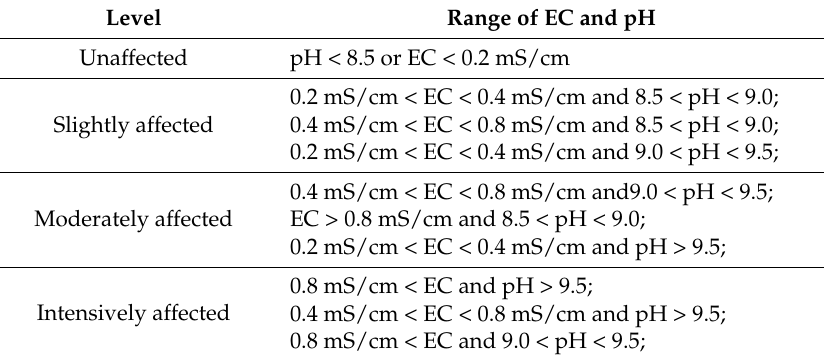
Table 6. The standard for soil HSS severity ranking.